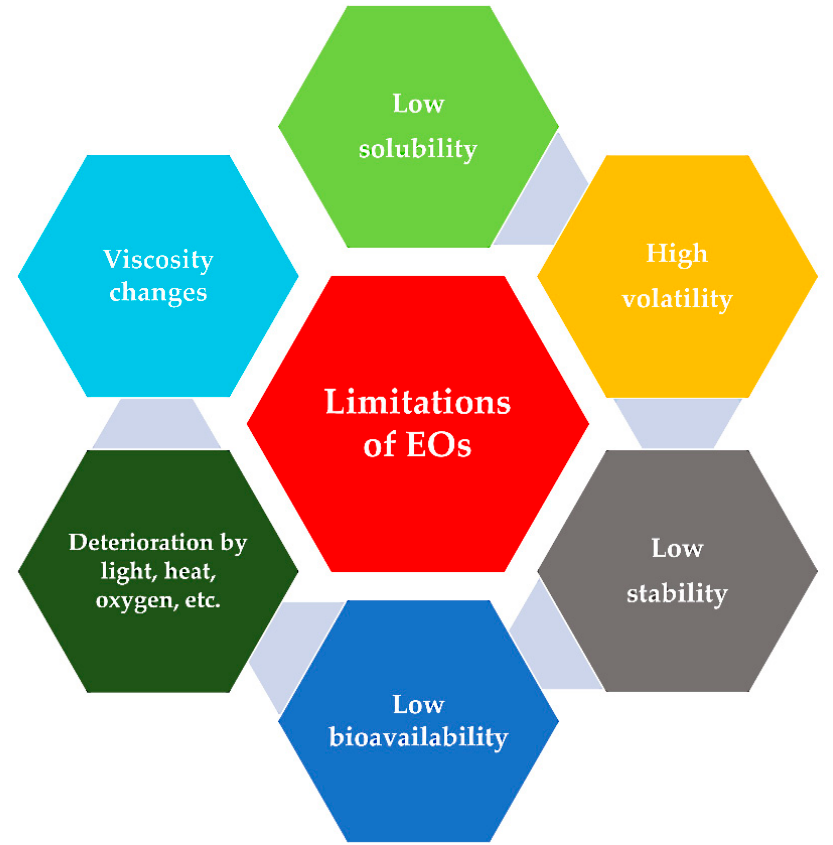
Figure 5. Schematic diagram highlighting the major limitations of Eos that prevent their use in clinical applications.